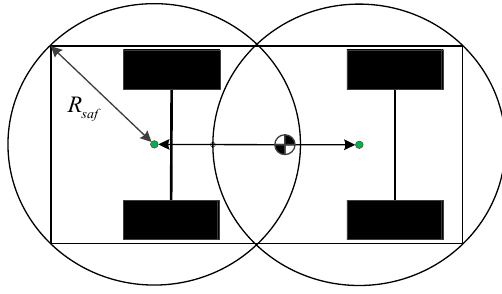
Figure 11. Circular expansion of the vehicle shape.